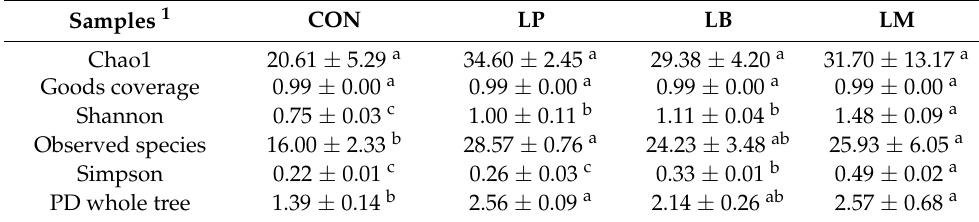
Table 1. Alpha index of Suancai fermented with different autochthonous LABs. Samples